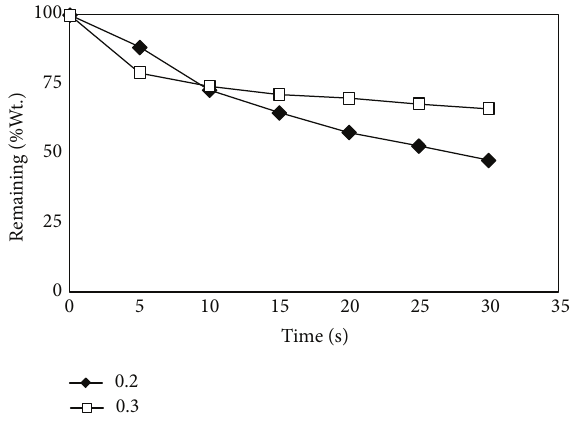
Figure 5: Effect of strength test on immobilized TiO 2 /DSAT